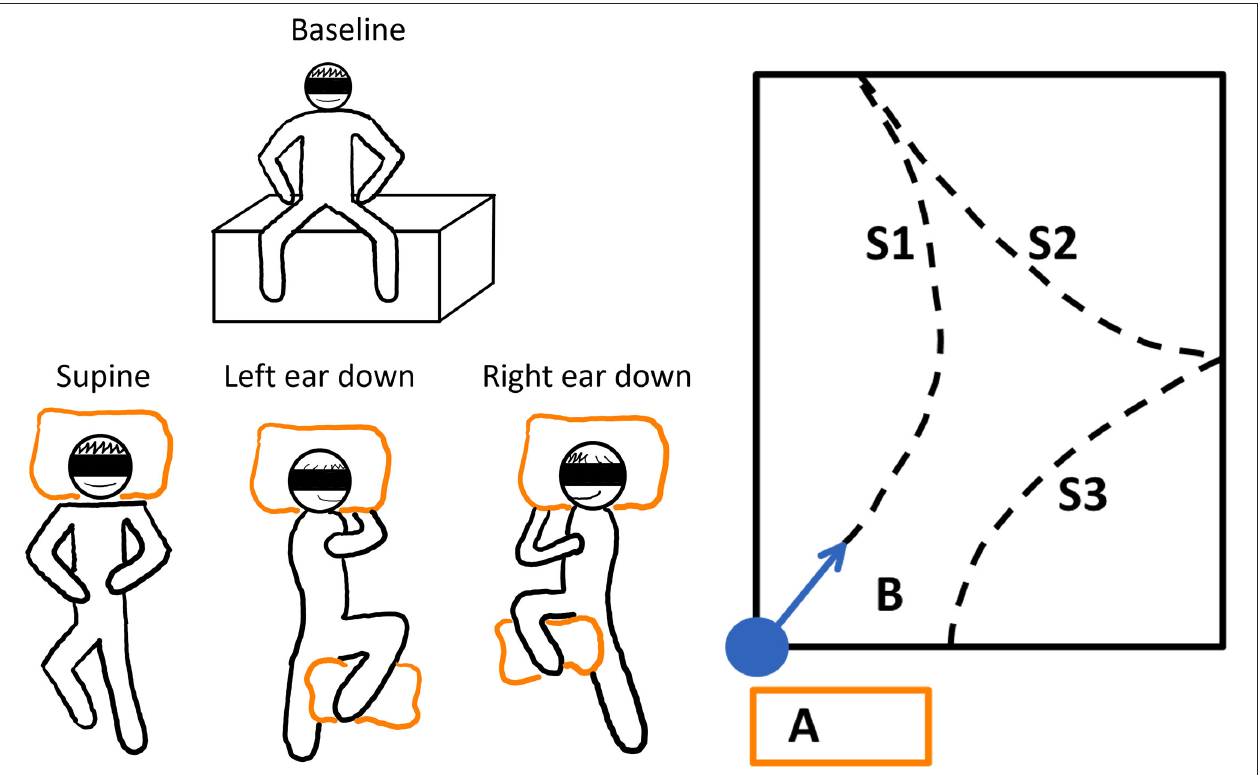
FIGURE 2 | The schematic illustration of the experimental paradigm. Left panel: The baseline resting position and the three different whole-body horizontal positions are depicted. To stabilize the subjects while lying, pillows were used (orange boxes). Each trial was repeated three times. The adaptation trials were performed in randomized order after the baseline trials. Right panel: The adaptation or resting phase was conducted on vaulting boxes at position A. The subjects were guided to the starting position, and they were realigned with the sports hall’s diagonal (B). The dashed lines show how a subject could have walked during the trials; WS1-3 denote the different